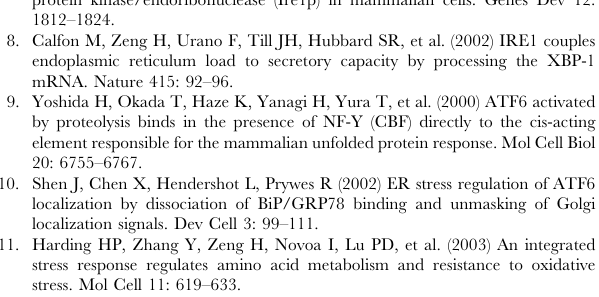
Figure 5. OASIS directly binds to the promoter region in the human VEGFA gene. (A) Schematic representation of the VEGFA promoter and the annealing sites of the primer set used in the ChIP assays. (B) PCR amplification of the VEGFA promoter region including the CRE-like site 4. ARPE-19 cells were transfected with a vector expressing the FLAG-tagged OASIS N-terminus. A GFP expression vector was used as a control. Immunoprecipitation was performed with anti- histone H3, anti-mouse IgG, or anti-FLAG antibodies, followed by the PCR using the specific primer sets. a template. ARPE-19 cells plated on 24-well plates were transfected with a reporter plasmid (0.1 m g) carrying the firefly luciferase gene and the reference plasmid pRL-SV40 (0.01 m g) carrying the Renilla luciferase gene under the control of the SV40 enhancer and promoter (Promega) together with 0.1 m g of each plasmid expressing an effector protein (mock pcDNA, FLAG- tagged OASIS N-terminus, XBP1 derived from spliced mRNA, ATF4, and ATF6 N-terminus) using Lipofectamine 2000 (Invitro- gen). After 48 h, the cells were lysed in 100 m l of 5 6 Passive Lysis Buffer (Promega). The firefly luciferase and Renilla luciferase activities were measured in 10- m l aliquots of cell lysates using a Dual-Luciferase Reporter Assay System and Luminometer (Promega). The relative activity was defined as the ratio of firefly luciferase activity to Renilla luciferase activity. Each sample was normalized by the value produced in mock wells. The assays were performed independently more than four times.